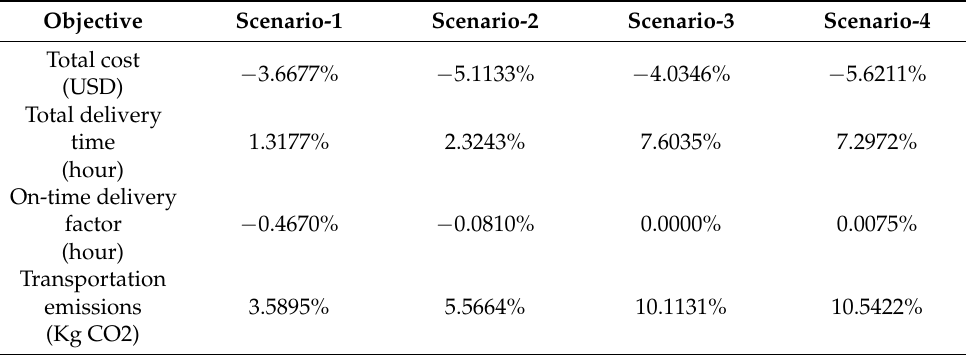
Table 12. Scenario’s objective functions performance